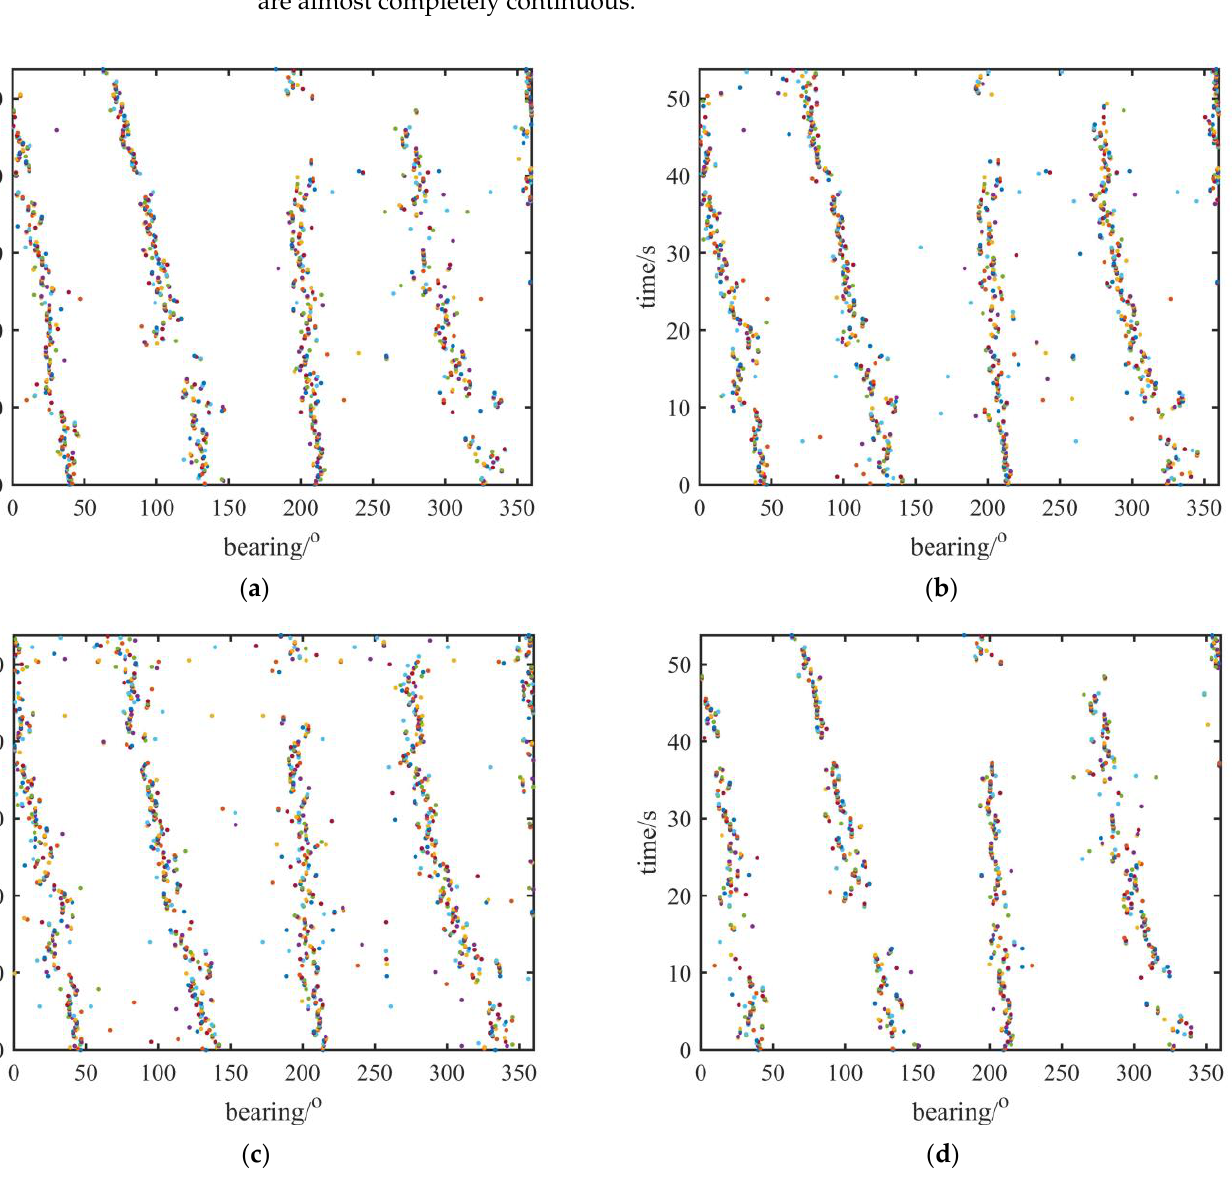
Figure 4. Traces of the boats in the first – fourth mode: ( a ) traces of boats in mode 1; ( b ) traces of boats in mode 2; ( c ) traces of boats in mode 3; ( d ) traces of boats in mode 4.